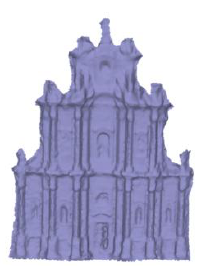
Figure 5. Model of the Visitationists Church in Warsaw in the form of a mesh